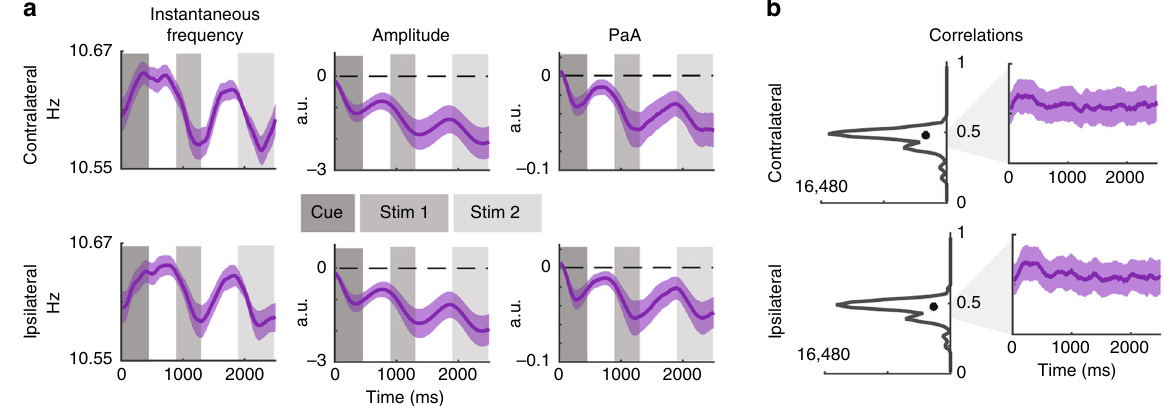
Fig. 7 Frequency, amplitude and PaA in Experiment 2. a Average instantaneous frequency, amplitude, and PaA in the same contralateral and ipsilateral electrodes examined previously, shaded areas indicate ± 1 SEM within subjects. All data are locked to the onset of the cue (indicated by dark shading). Alpha amplitude shows event-related decreases corresponding to the onset of the cue, stimulus array 1 and stimulus array 2. Similarly, the rightmost panel shows that average shifts in PaA mirror these changes in amplitude. b Histogram of single trial correlations collapsed across subjects, timepoints, and electrodes. Traces to the right indicate timecourses of these correlations. Timecourses show these correlations are relatively stable over time, where the y - axes of the plots run from 0.4 to 0.5, corresponding to the gray shaded area in the histogram